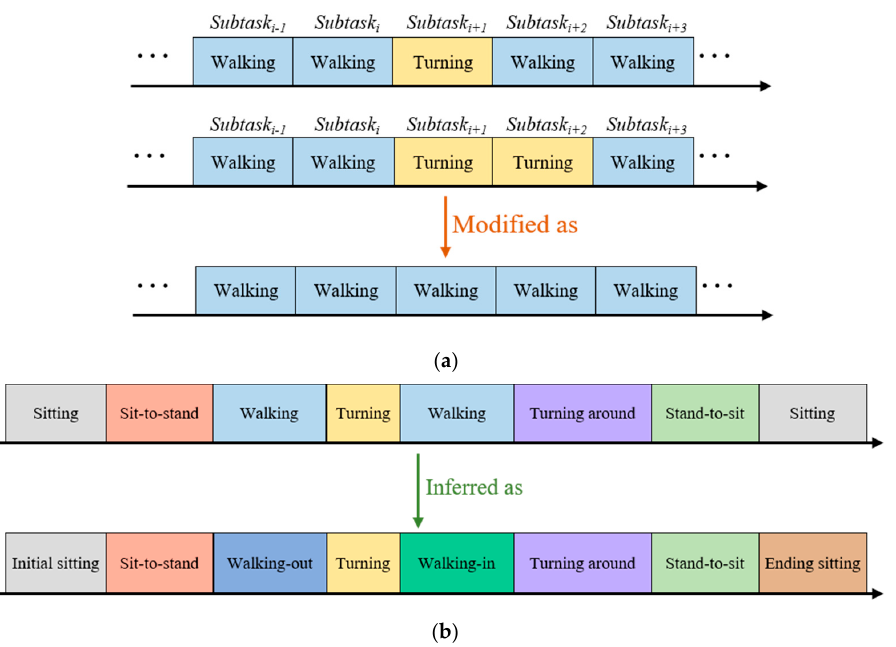
Figure 6. The knowledge-based postprocessing: ( a ) the fragmentation modification and ( b ) the motion